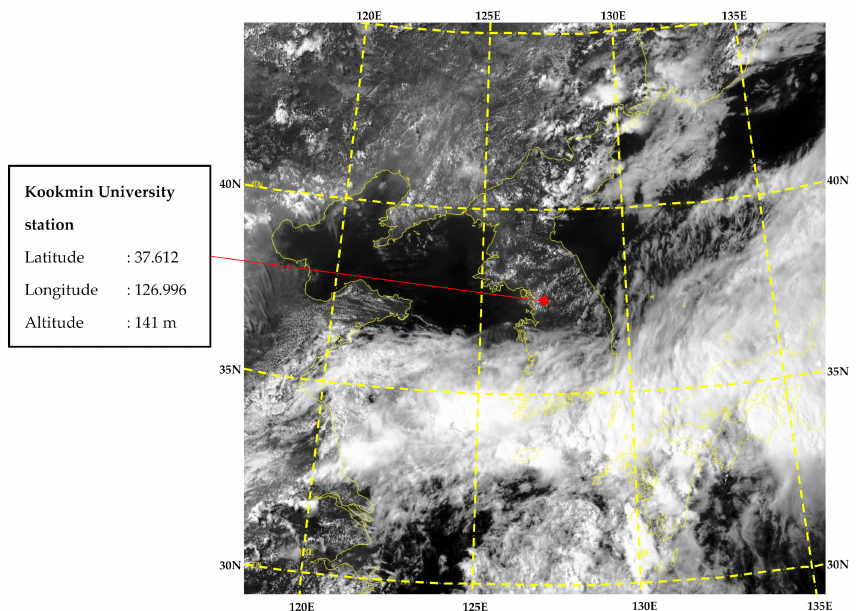
Figure 1. Example of a satellite image from visible channel provided by COMS (Communication, Ocean, and Meteorological Satellite), stationed at 36,000 km above the equator. This image is considered as level 1B